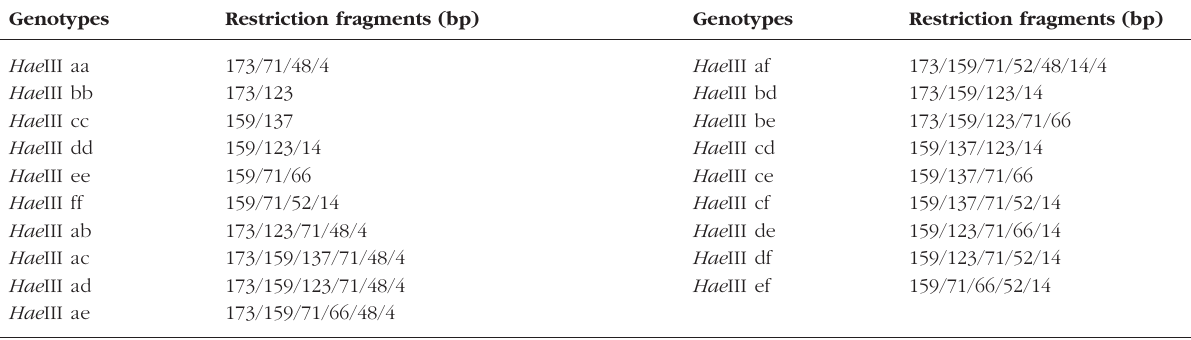
Table II. – The genotypes of PCR-RFLP by restriction enzyme Hae III in the second exon of the Ovar- DRB 1 gene.